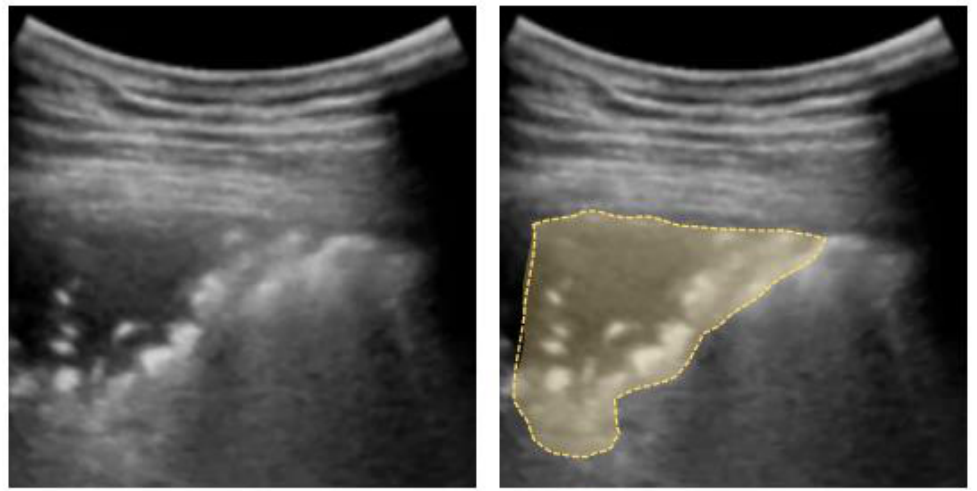
Figure 6. Shred sign: small nontranslobar echo-poor consolidation delimited by irregular boundaries (outlined).